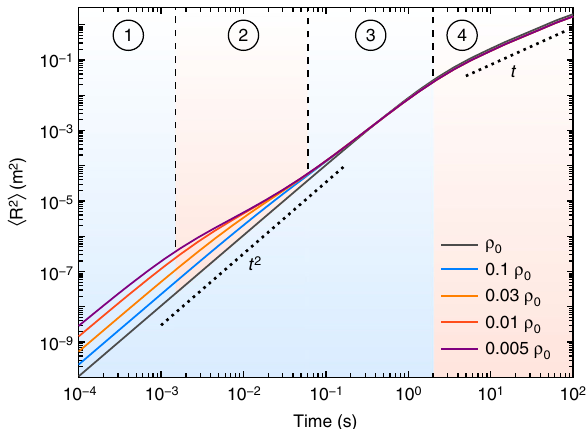
Fig. 6 Time dependence of MSD for gradually decreasing density. MSD of hypothetical particles with successively reduced material density (i.e. M and J are reduced by a common fraction). The other parameters are fi xed as M = 4 g, J = 1.5×10 − 7 kg m 2 , ξ / M = 6.5 s − 1 , ξ 0 0 visible. When the density drops below 0.01 ρ 0 the MSD divides into four regimes: 1. inertial ballistic, 2. short-time diffusive, 3. active ballistic and 4. active diffusive. In the limit of large damping and vanishing torque the 1 – 2, 2 – 3 and 3 – 4 transition times are given by M / ξ , D = 2 V 2